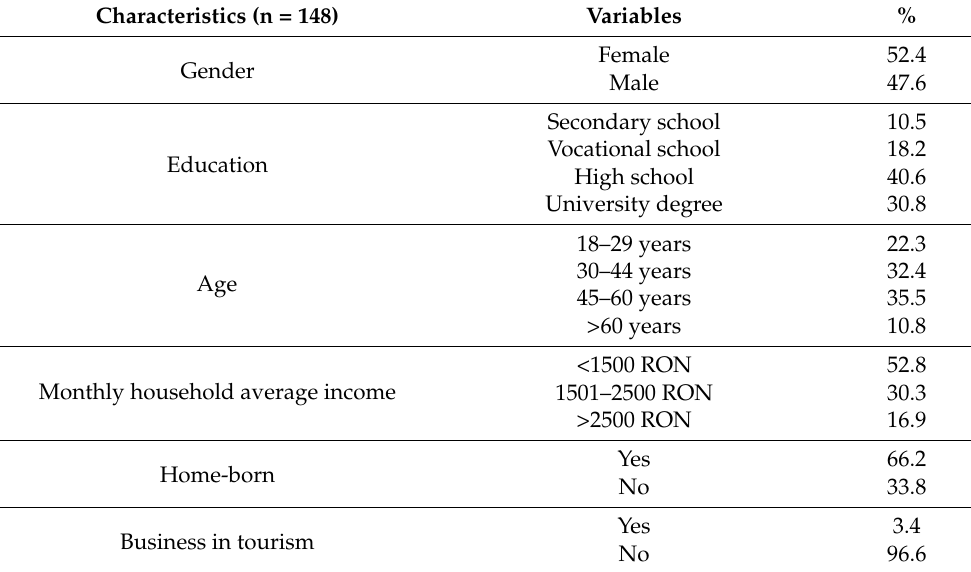
Table 2. Socio-demographic characteristics of the